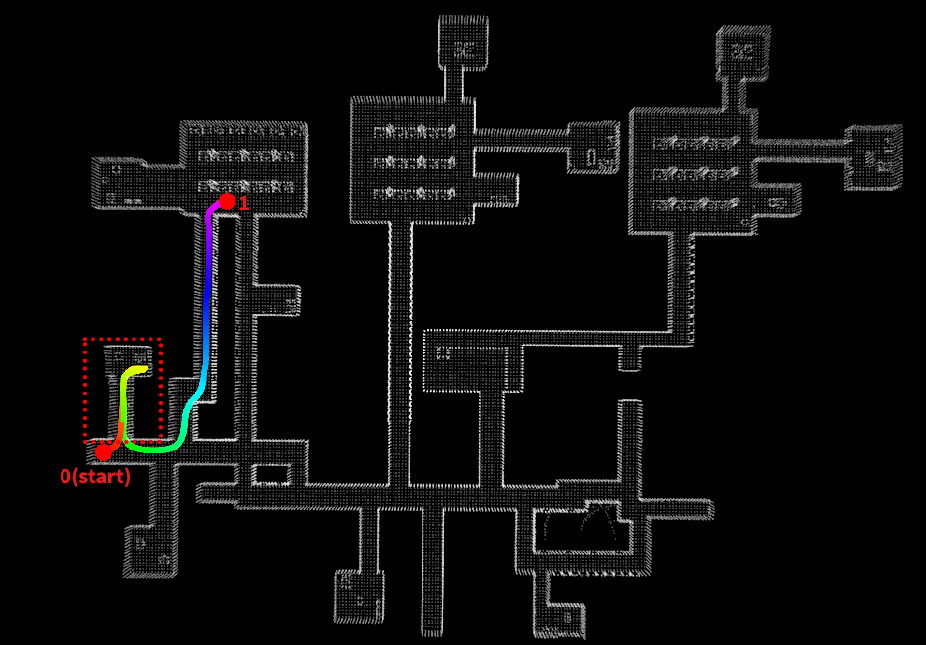
Figure 12. The robot travels from position 0 to position 1, and the red dotted box represents the wasted exploration space during